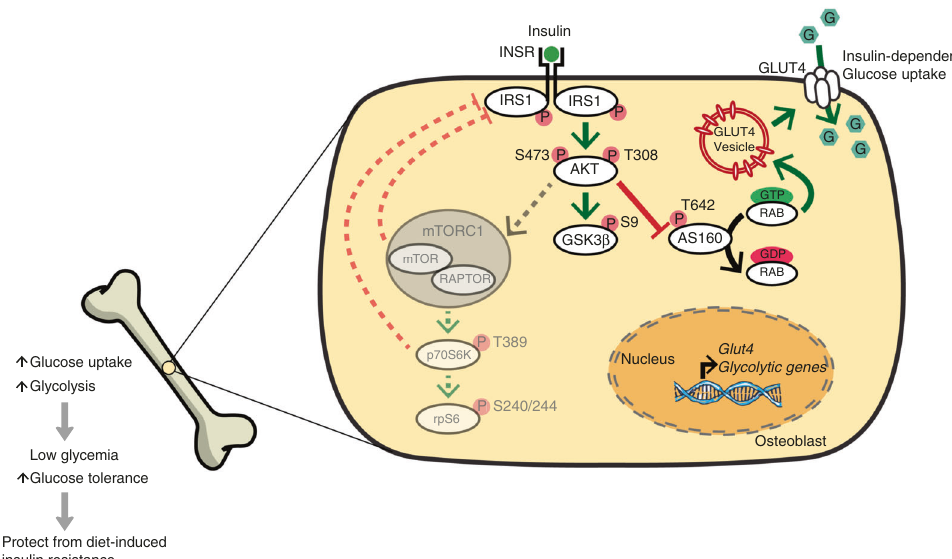
Fig. 9 Schematic: Suppression of mTORC1 activity in pre-OBs results in relaxation of mTORC1-dependent negative feedback control (both directly and indirectly via activation of p70S6K) of insulin signaling by disrupting the interaction between IRS1 and INSR. This lead to an enhanced and prolonged insulin signaling as indicated by hyperactivation of AKT at Ser 473 and Thr 308 in both basal and insulin-stimulated states. AKT hyperactivation attenuates the inhibitory effects of the AS160 on RAB leading to GLUT4 membrane translocation. These molecular changes are associated with an increased cellular glucose uptake in the Rptor KO OBs and upregulation of an insulin-dependent glucose transporter 4 ( Glut4 ) and glycolysis-promoting enzymes in the skeleton of Rptor ob − / − mice. Systemically, Rptor ob − / − mice showed persistently low fasting glucose levels and signi fi cantly increased tolerance to glucose; the metabolic phenotypes which are, at least in part, attributable to an enhanced responsiveness to insulin and insulin-dependent glucose uptake in